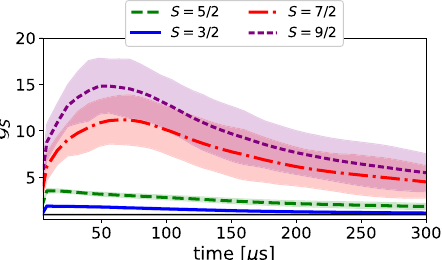
Fig. 4 Gain, de fi ned in Eq. (9), with respect to non-corrected spin 1/2 for the data in Fig. 3. The curves indicate the average of G S ð t Þ over the different nuclear spin spatial con fi gurations (generated as explained in “ Methods ” ), while the shaded areas mark the region included between G S ð t Þ ± σ S ð t Þ , where σ S ð t Þ ¼ the standard deviation and 〈 ⋅ 〉 denotes averaging. The shaded areas show that a large gain is obtained for all spatial con fi gurations at given spin S . The standard deviation σ S ( t ) increases with S since the denominators in Eq. (9) become smaller and smaller for increasing S . A comparison with spin-binomial codes is further given in “ Methods ” .